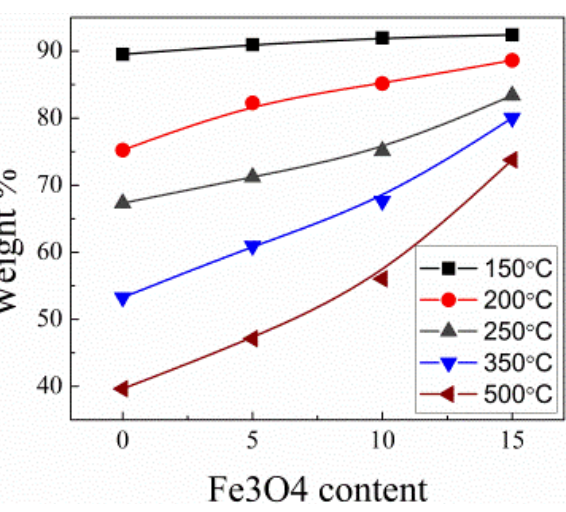
Figure 8: TGA curves for polymer blend and their Fe 3 O 4 nanocomposite samples a) from 70 to 500 ∘ C b) from 125 to 250 ∘ C and c) Depen- dence of weight loss on magnetite weight ratio at different